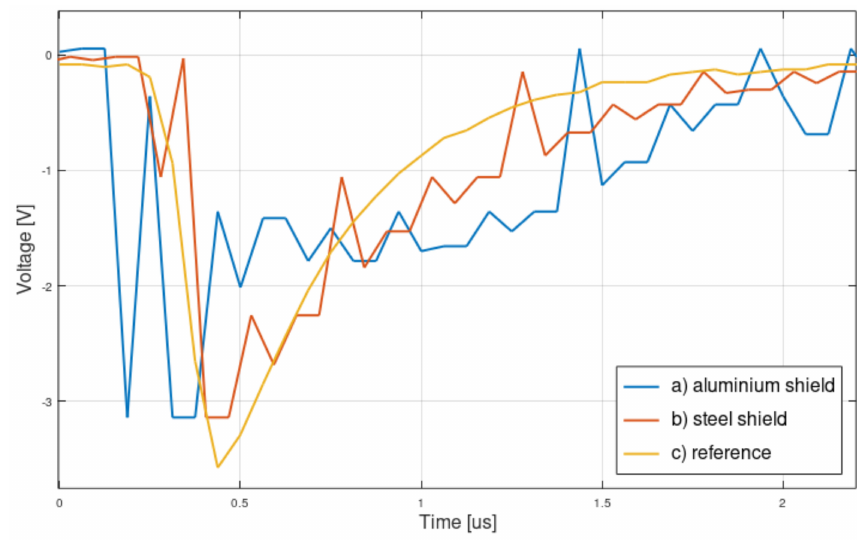
Figure 7. Shielding material